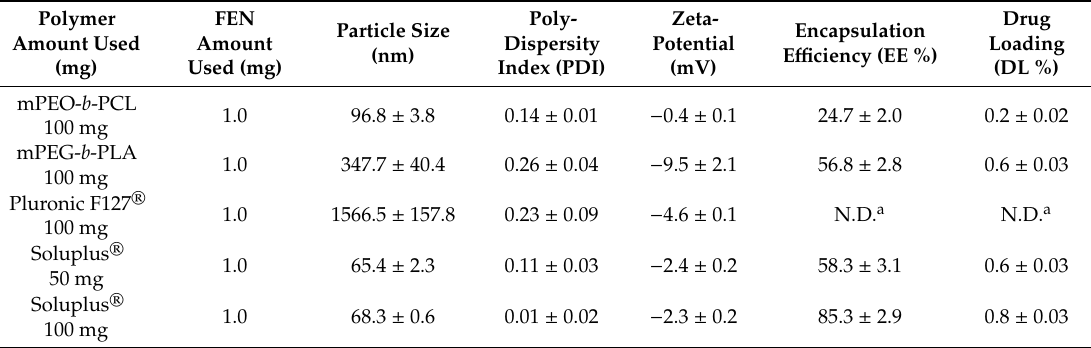
Table 1. Characteristics of fenbendazole (FEN)-loaded